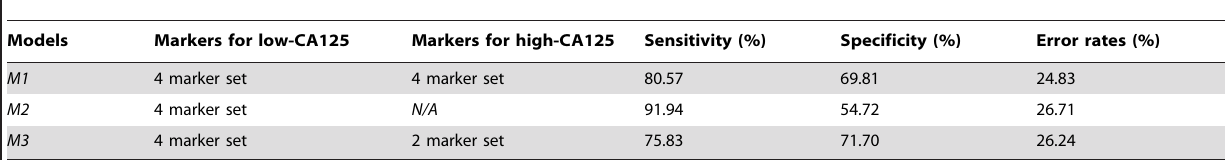
Table 5. Sensitivity, specificity and error rates of the selected two-step models.